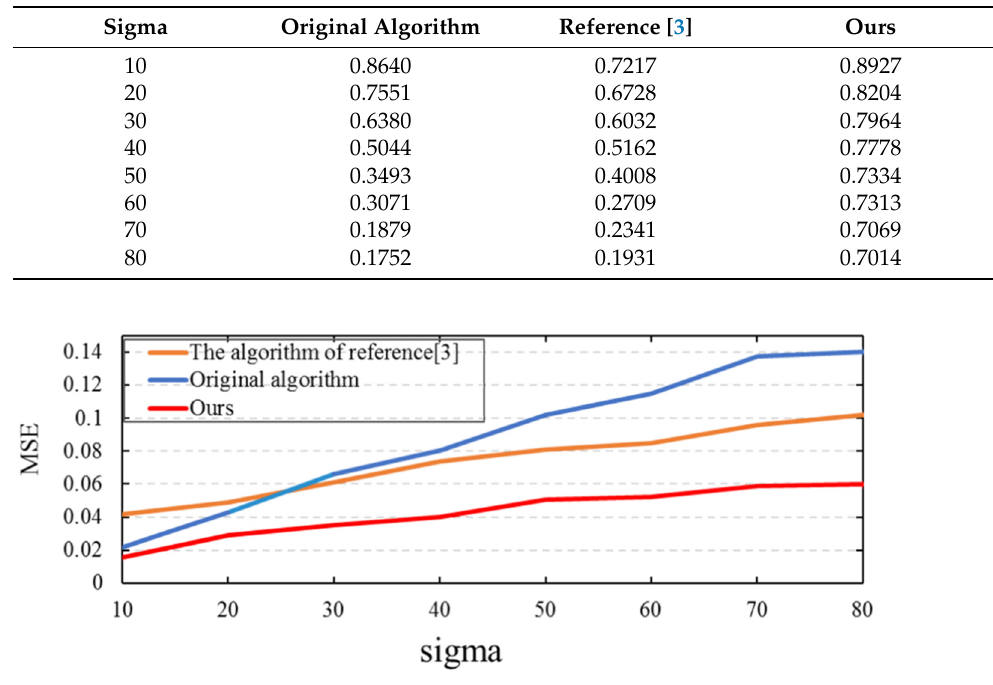
Figure 7. PSNR line chart of the three algorithms for the Monarch image.